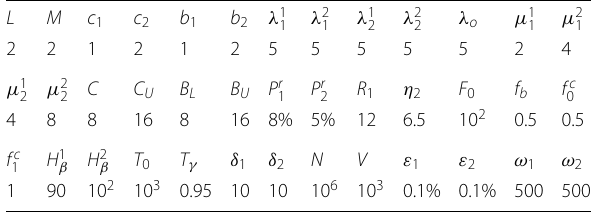
Table 2 Default simulation